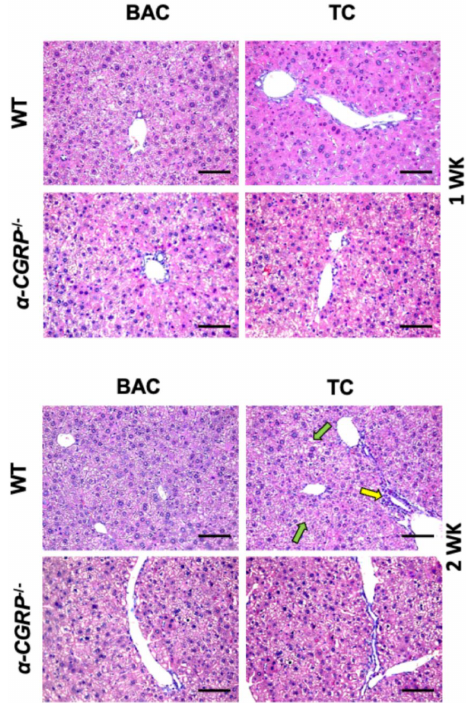
Figure 2. Evaluation of liver histology infiltrates by H&E staining in liver sections from all exper- imental groups of mice. H&E staining showed lobular inflammation consisted of infiltration of polymorphonuclear cells (yellow arrows) in WT mice fed the TC diet for 2 wk compared to WT mice fed the BAC diet and WT mice-fed the TC diet for 1 wk. In addition, the TC diet for 2 wk in WT mice induced swelling, ballooning, and damage of hepatocytes (green arrows). The phenotypes were ameliorated in α -CGRP − / − mice fed the TC diet for 2 wk compared to WT mice treated with the TC diet for 2 wk. Original magnification 20 × ; scale bar 50 µ m. Data are analyzed from n = 6 animals per each experimental group. Data are reported in Table